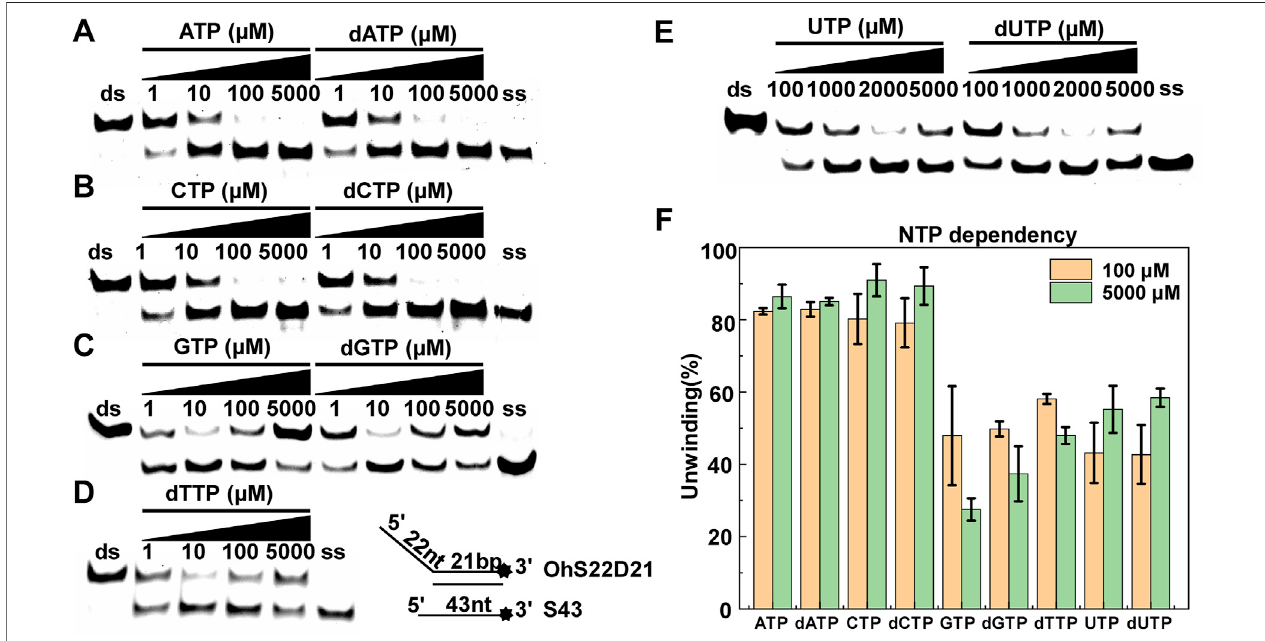
FIGURE 4 | NTP/dNTP preference of CaPif1. DNA was unwound in the presence of the indicated NTP or dNTP (A – E) . The 5 ′ -overhanged DNA substrate (OhS22D21) and CaPif1 concentrations were 25 nM, and the unwinding reaction was initiated with various NTP or dNTP concentrations. Lane ds: duplex DNA is not unwound, unwinding buffer (no ATP); Lane ss: single DNA with 3 ′ - fl uorescein (3 ′ -FAM) (shown in Table 1 ). The numbers above the line indicate the concentrations of NTPs and dNTPs ( μ M). (F) The proportion of unwinding DNA (Supplementary Table S3)